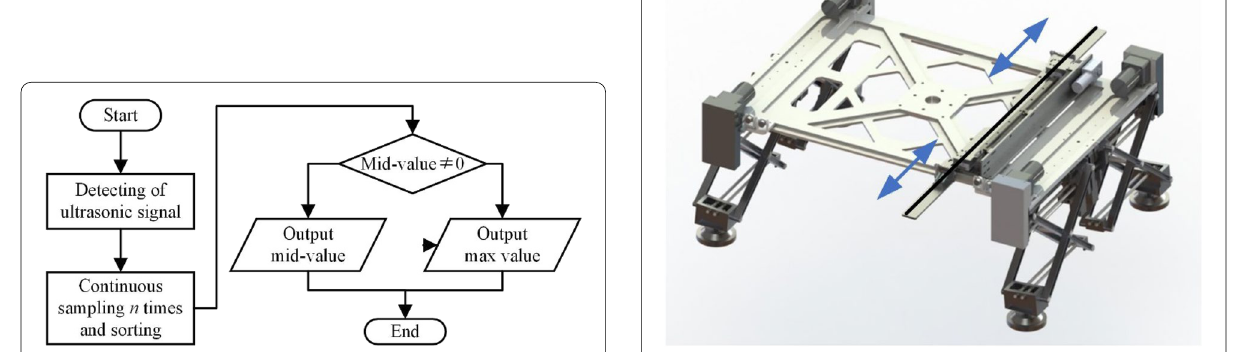
Figure 7 Docking mechanism in short